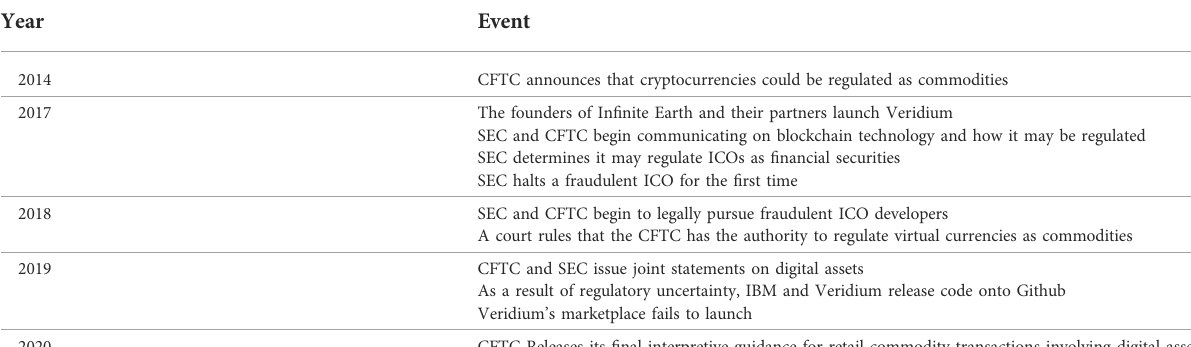
TABLE 4 Timeline of events regarding Veridium and regulatory uncertainty. The timeline shows that Veridium launched in 2017, the same year as the SEC and CFTC began taking public action on digital assets. The SEC & CFTC would begin to regularly pursue fraudulent uses of blockchain technology(particularlyforICOs).Uncertaintyoverhowthesetwoagencieswouldultimatelyregulatedigitalassets(andwhichagencywoulddoso) led to Veridium failing to launch its marketplace. Veridium would release its code onto the code repository website Github for the open-source community in 2019. In 2020, the CFTC would release its fi nal guidance for commodity transactions involving digital assets. Timeline of Major